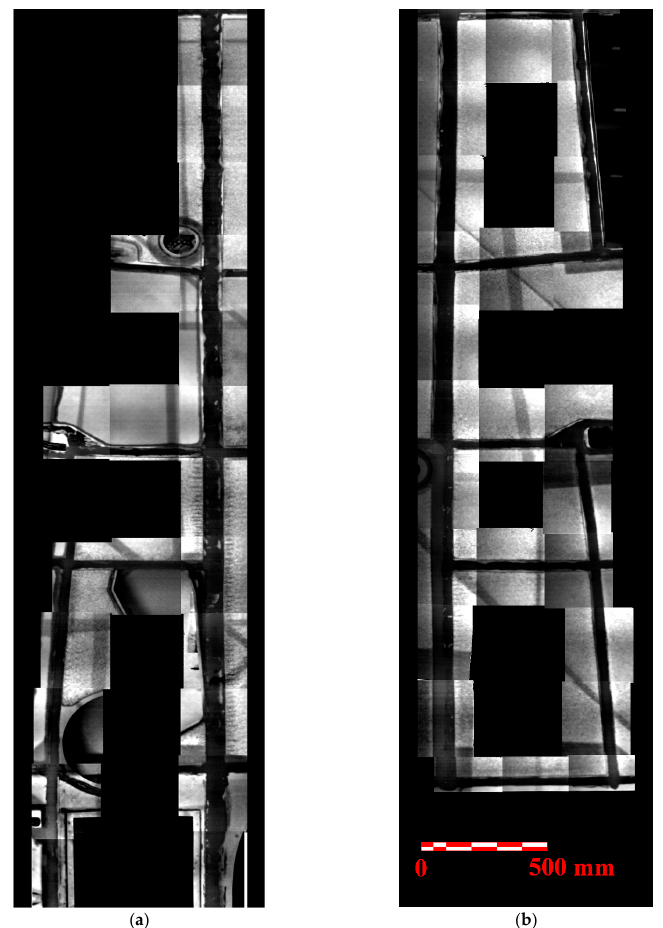
Figure 22. Results of the PT NDE method—overview image of the tested wing area: ( a ) lower wing side on the left; ( b ) upper wing side on the right.